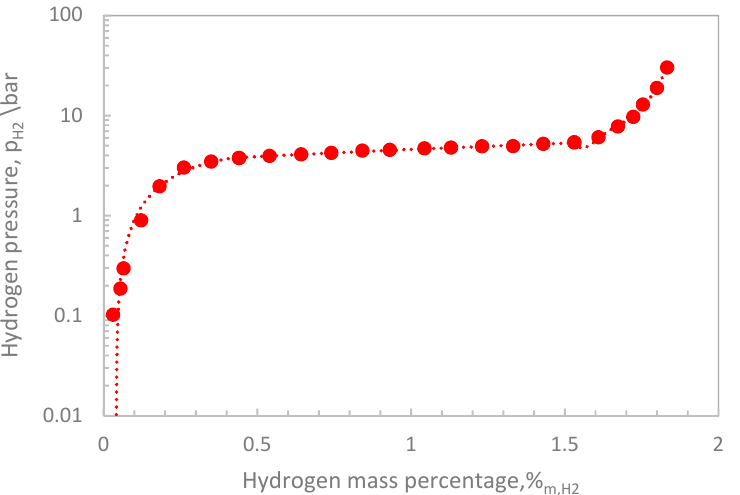
Figure 4. Comparison between the theoretical Metal Hydride PCT desorption curve and experimental data, supplied by the manufacturer at the typical operating temperature (20 °C).